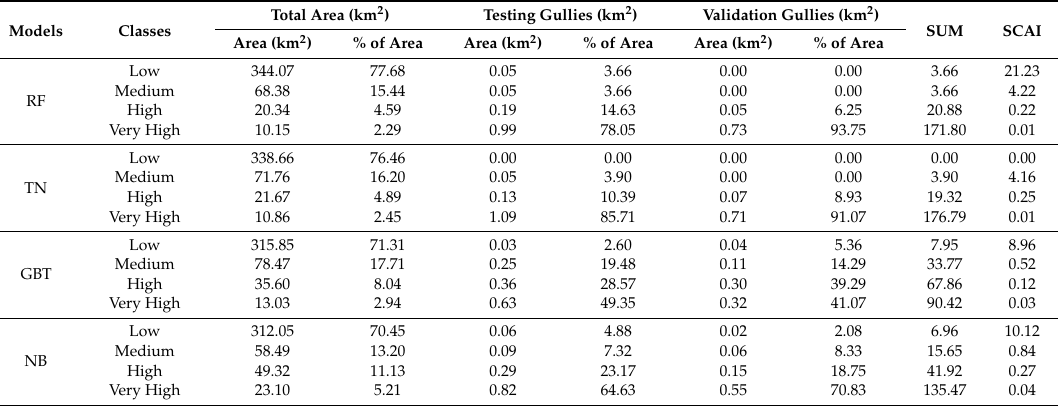
Table 4. Seed cell area index (SCAI) values of RF, NBT, GBRT, and TE models.